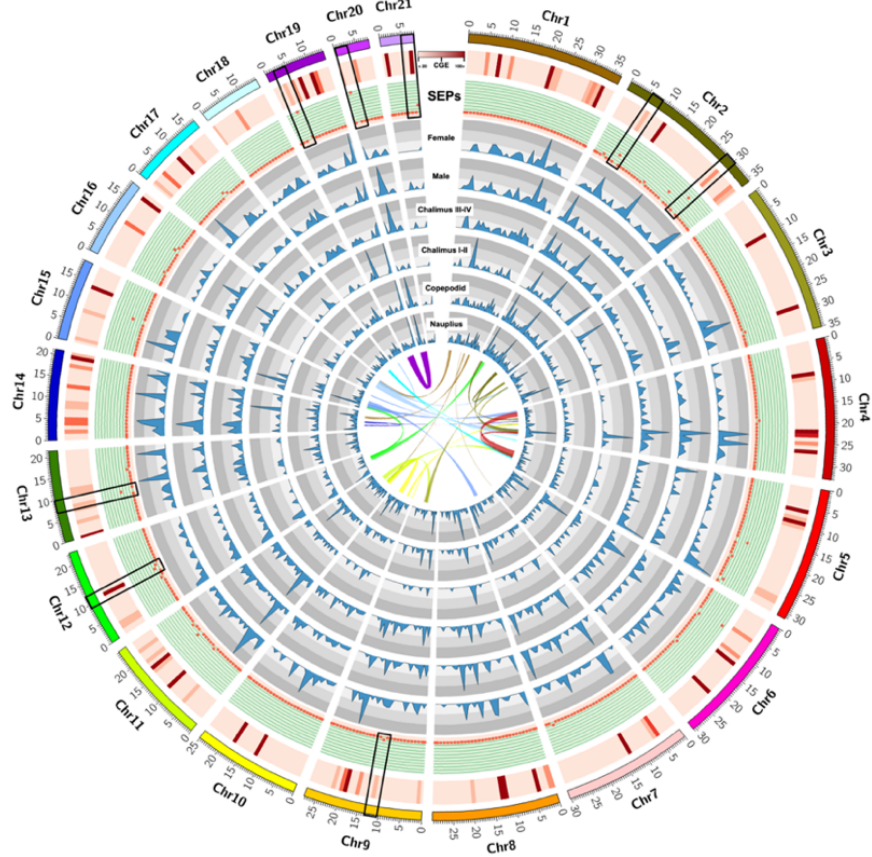
Figure 1. Caligus rogercresseyi transcriptome showing threshold areas for differential gene expression activity during the ontogeny. The graph tracks identify graph regions that fall between 10–20 K reads of coverage values of each chromosome. CGE index: heatmap in red showed the differences in expression variation among sea lice developmental stages. SEPs: red dots represent the secretome-related genes on each differential chromosome region. Blue profiling indicates the transcriptome coverage for each ontogenetic stage. Syntenic relationships of gene blocks among C. rogercresseyi pseudochromosomes are also displayed.